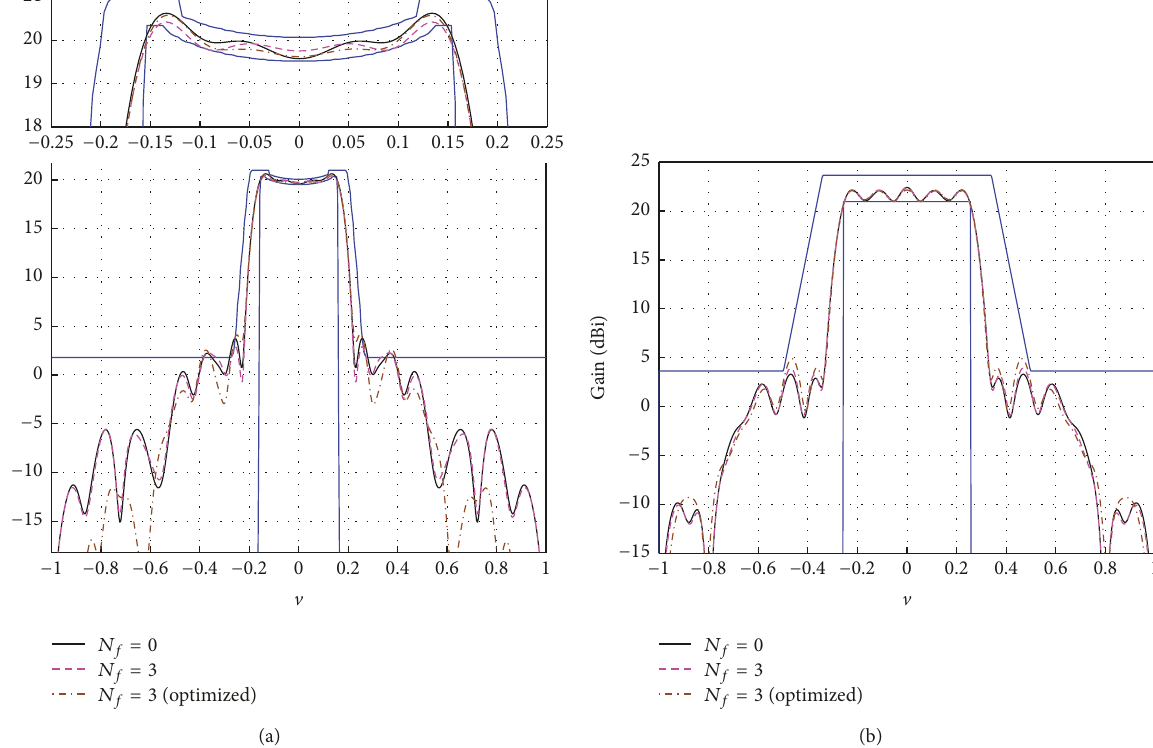
Figure 9: Comparison of the simulations between the reflectarray with frame taken into account in the synthesis and without frame, for 𝑋 polarization. 𝑁 𝑓 indicates the number of extra elements added as dielectric frame at each edge of the reflectarray. (a) Symmetric cut of isoflux pattern. (b) Azimuth cut of LMDS